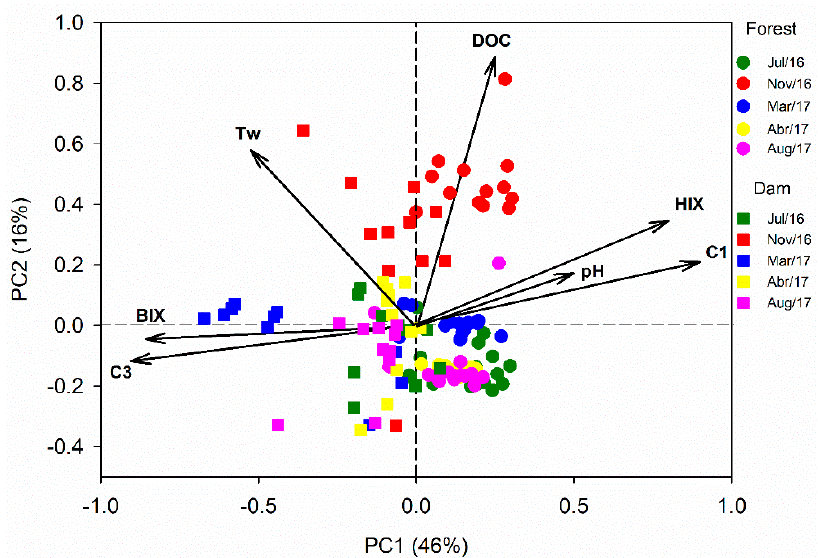
Figure 7. Graphical representation of the load factors for the input variables and scores plot for water samples collected in the different catchments (square for Dam and circle for Forest) and hydrological month (different